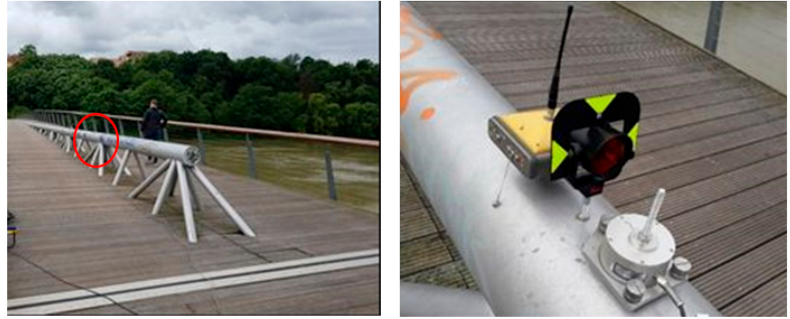
Figure 1. Location of the measuring point on the bridge over the river Drava. Vibrations for measuring the dynamic response of the bridging structure were induced by two people with a total mass of 160 kg running away from the measuring point. Geodetic measurements were performed with two Total Robotic Station (RTS) Leica TS50 and TS30. The apparatus measures the change in the horizontal and vertical angles to the geodetic target. The third measuring device was the Topcon Hiper Pro Global Navigation Satellite System (GNSS), which allows dynamic observation of a measuring point based on measured distances to satellites. Physical measurements were performed using an Instantel Minimate Plus seismograph with a triaxial geophone. The basic characteristics of measuring equipment are shown in Table 1.